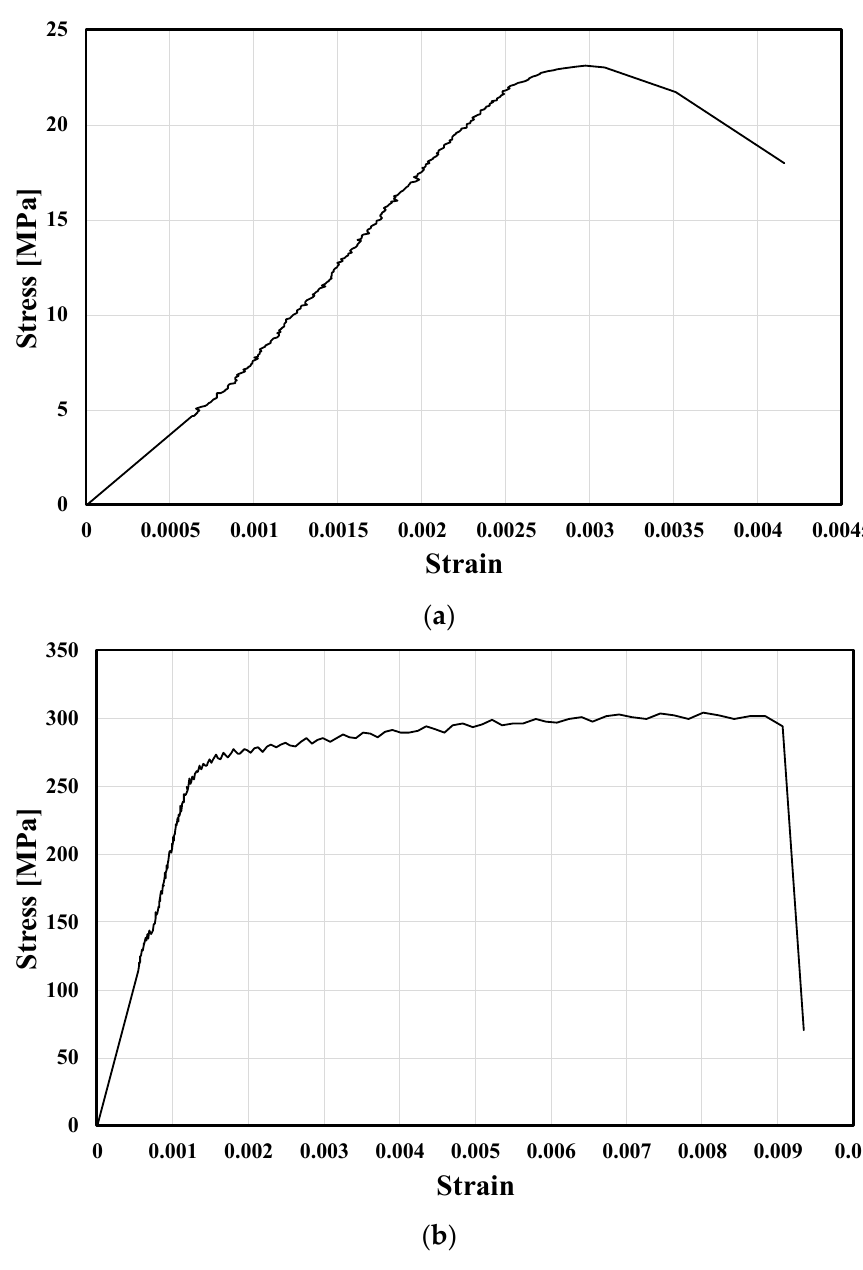
Figure 8. ( a ) Compressive strength test of concrete; ( b ) Tensile test of steel plate.